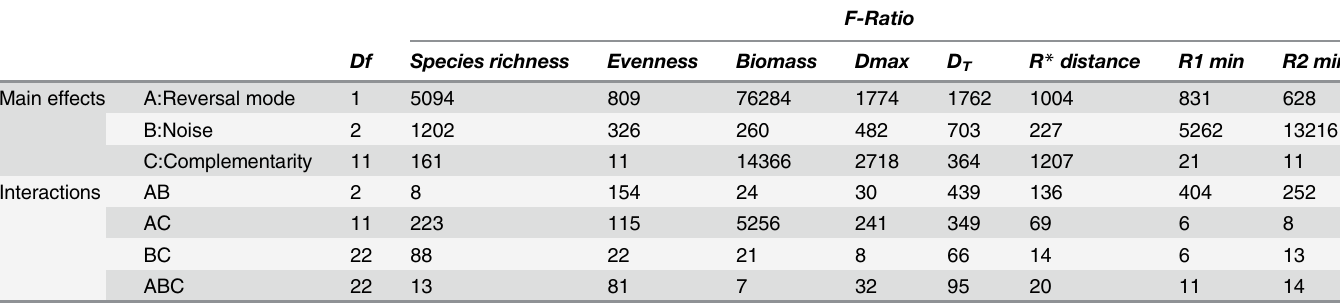
Table 1. F-ratios resulting from Analysis of Variance on the effects of fluctuation type, noise and complementarity levels and their interactions on multiple assemblage characteristics (e.g. biomass, richness,